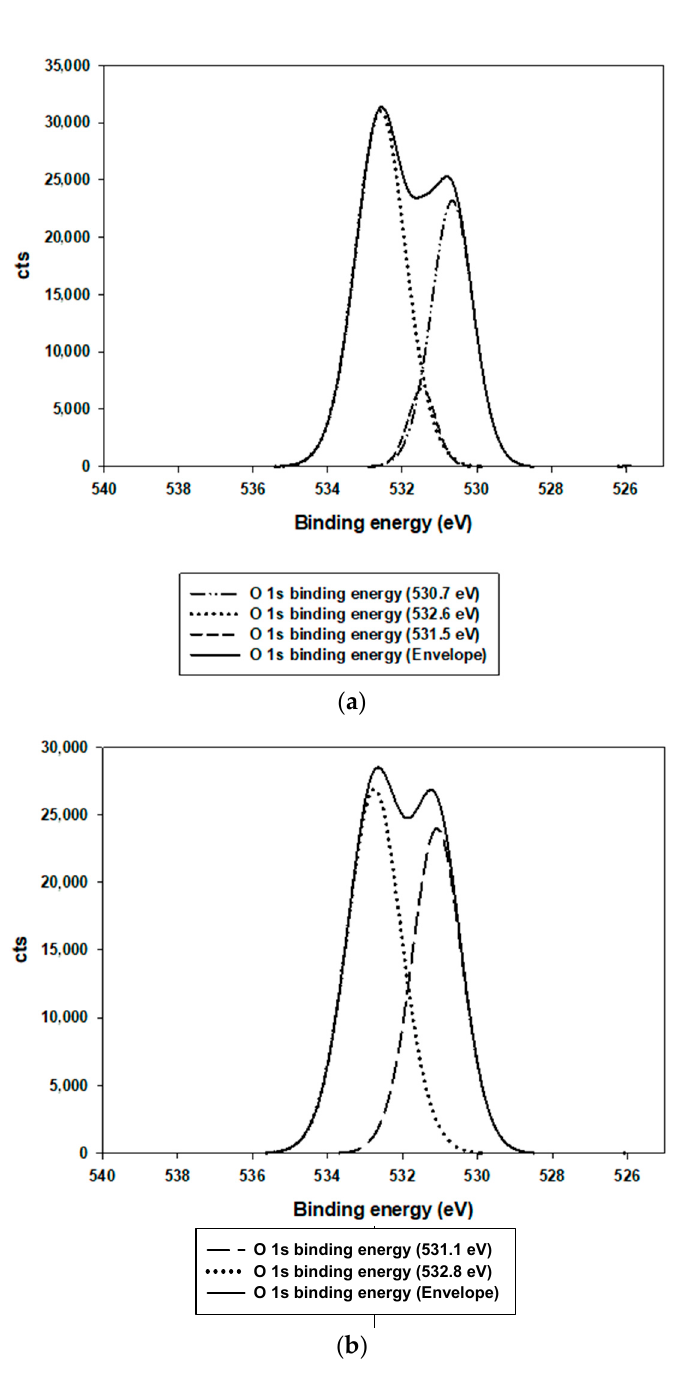
Figure 8. O 1 s XPS spectra: ( a ) Outside the wear track; ( b ) Inside the wear track.